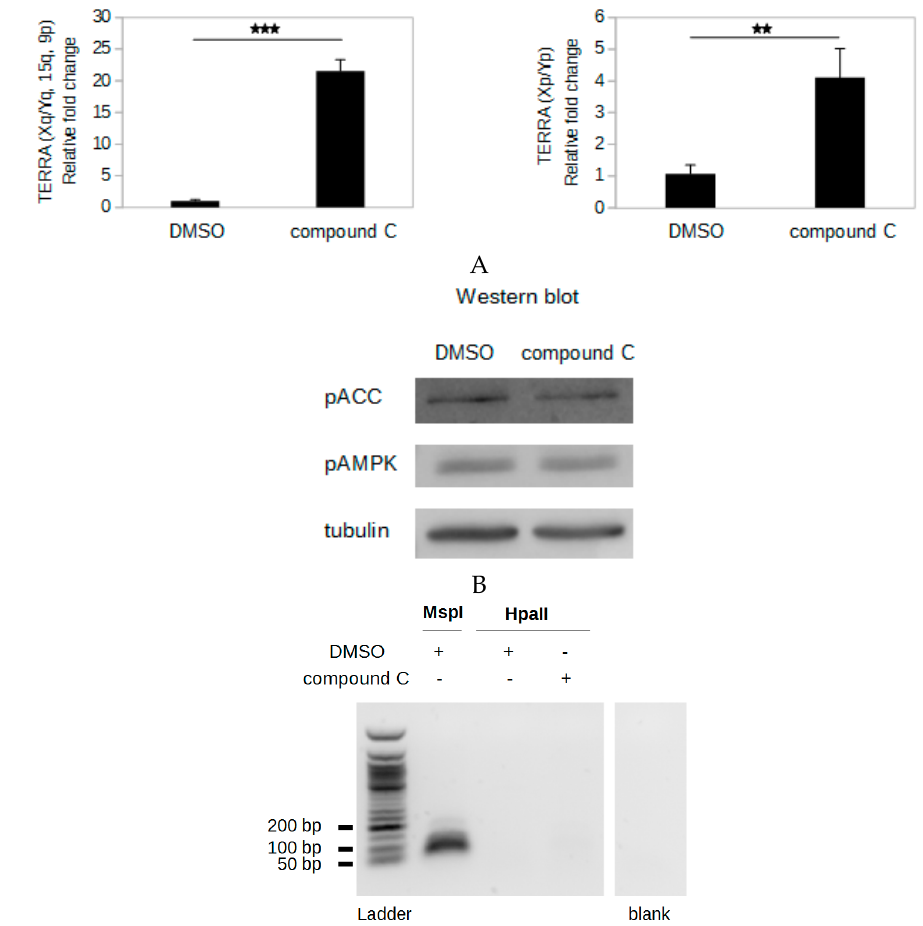
Figure 4. Compound C induces an increase in TERRA levels in HeLa cells. HeLa cells were treated with dimethyl sulfoxide (DMSO) or compound C (5 µ M). DNA, RNA, and proteins were extracted after 18 h of treatment. ( A ) TERRA from subtelomeres Xq, Yq, 15q, and 9p and TERRA from subtelomeres Xp and Yp was quantified by RT-qPCR using TR / TF and Xp-R / Xp-F primer pairs, respectively; levels were normalized to GAPDH mRNA, and all values were compared to DMSO-treated sample. The bars represent the average values from three biological and two technical replicates for each sample. Error bars represent the standard deviations. p values were calculated by paired two-tailed Student’s t-test ( n = 3). ** p < 0.01. *** p < 0.001. ( B ) Western blot analysis of the phosphorylation of AMP-activated kinase (AMPK) and acetyl-CoA carboxylase (ACC). Tubulin was used as a loading control; 15 µ g of total protein was loaded in each well. This result is representative of five independent experiments. ( C ) Analysis of the methylation of the 29 bp repeats using the method described in Figure 1B. Genomic DNA (500 ng) was digested with HpaII (methyl sensitive) or MspI (methyl insensitive). A sample without DNA (blank) was used as negative control. Elongation products (1 / 20 of sample) were amplified by PCR (35 PCR cycles). PCR products were run on a 1.5% BET-agarose gel. Ladder is the 50 bp DNA ladder (New England